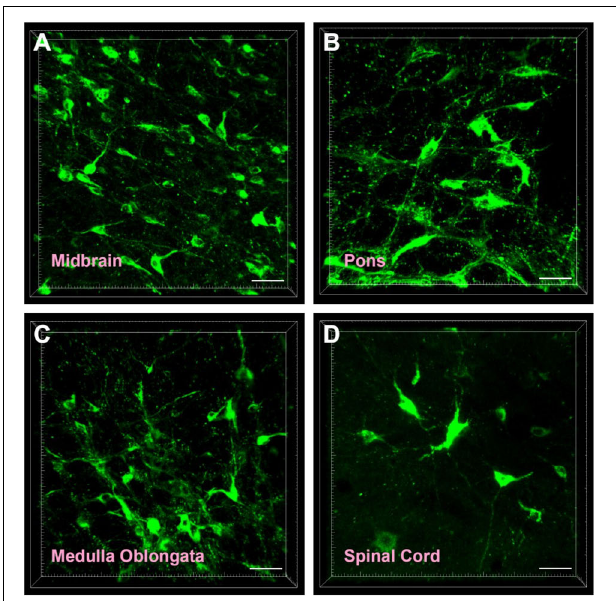
FIGURE 2 | Cellular morphology of CB-positive neurons. Representative photographs from the midbrain (A) , pons (B) , medulla oblongata (C) , and spinal cord (D) . Scale bar = 40 µ